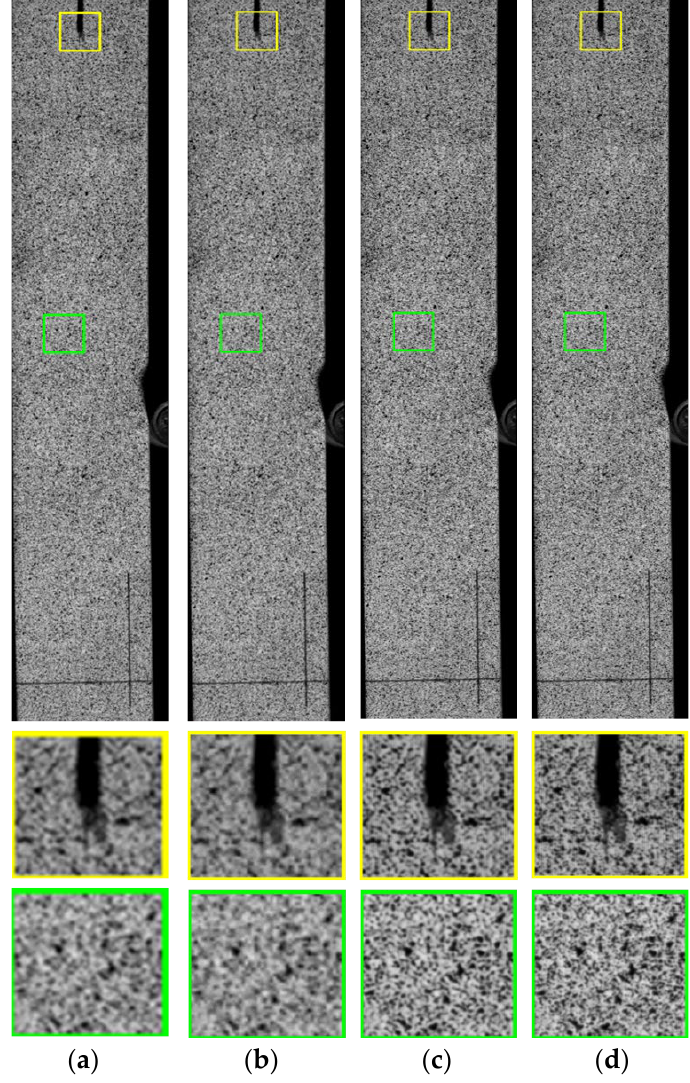
Figure 12. Comparison of reconstructed image effects. ( a ) Low-resolution (LR) image; ( b ) image reconstructed using BICUBIC B-spline interpolation method; ( c ) image reconstructed using SRResNet method; ( d ) image reconstructed using ADRN method.